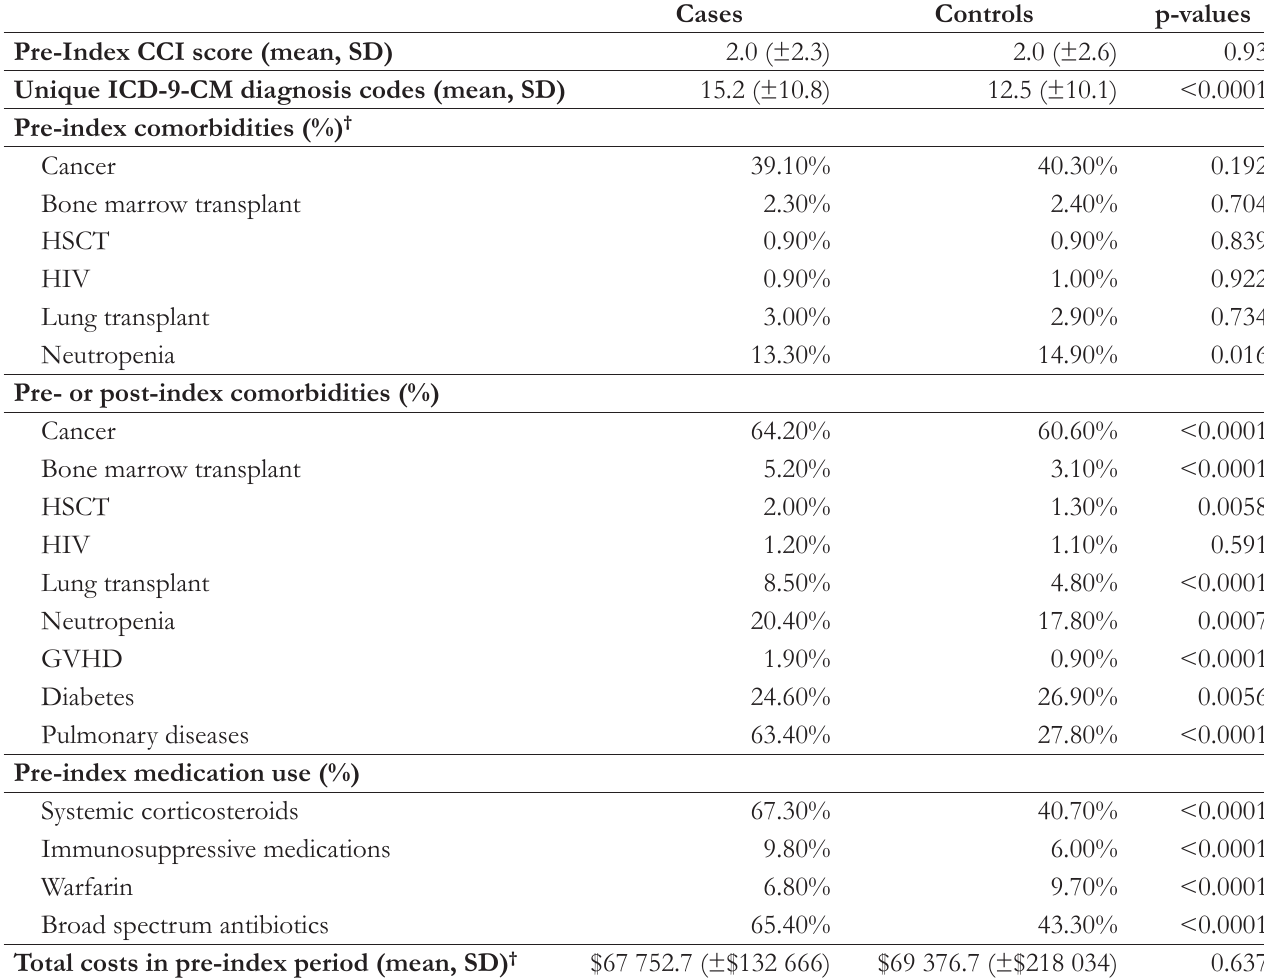
Table 2. Pre-Index Clinical Characteristics of Aspergillosis Cases and Propensity Score-Matched Controls Cases